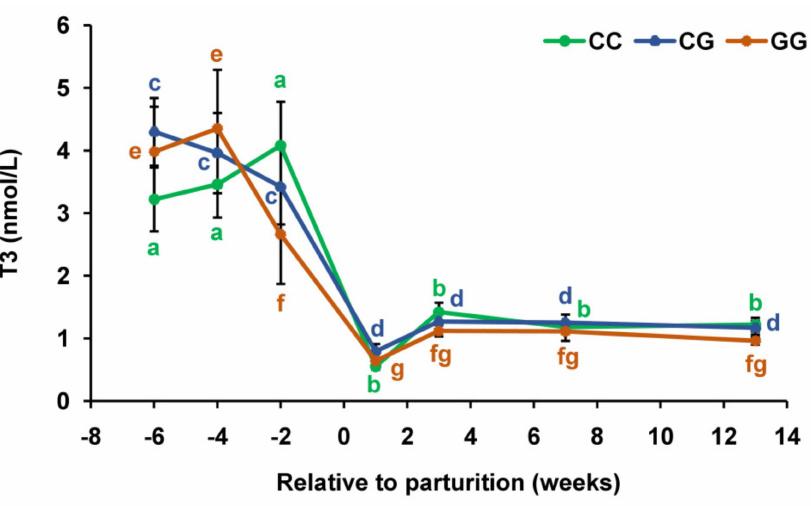
Figure 2. Serum total thyroxine (T4) concentrations during the prepartum and postpartum periods in dairy cows with polymorphic variants of the DIO1 gene. Means with different letters differ significantly within each group (at least p < 0.05). + p < 0.05 (between CG and GG genotypes). The content of T3 in the blood of cows with the CC and CG genotypes decreased ( p < 0.001) between the second week before calving and the first week of lactation (Figure 3). However, in carriers of the CC genotype, this decrease was more acute (by 7.4 times) than in those of the CG genotype (by 4.3 times). In animals with the GG genotype, a significant decline in the concentration of T3 (by 1.6 times) was noted earlier, between the fourth and second weeks of the prepartum period, but the maximum decrease (by 6.8 times) also occurred by the first week of lactation.